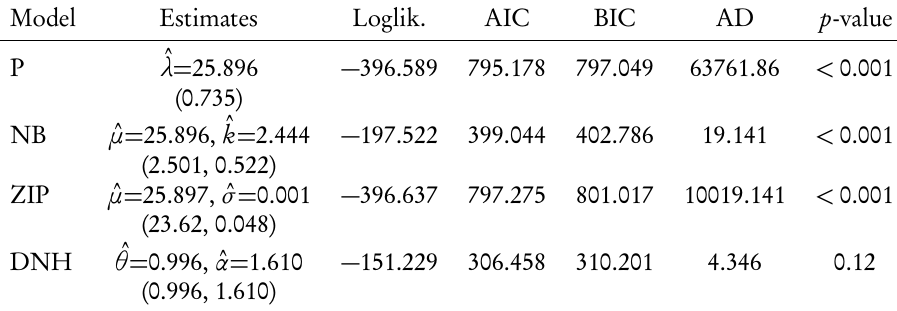
Model summaries for data on examination marks in